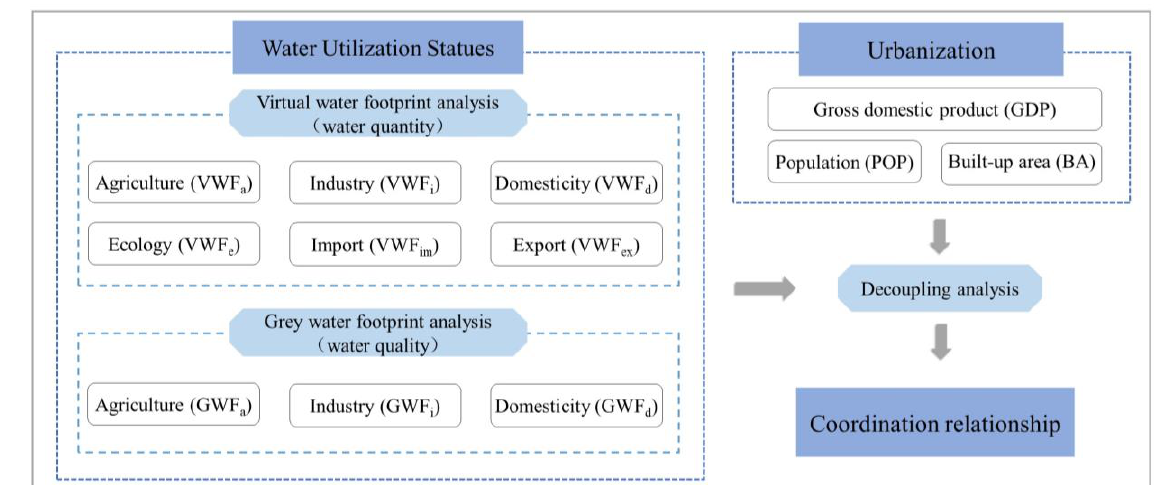
Figure 2. The research framework of this study. VWF a : agricultural virtual water footprint, VWF i : industrial virtual water footprint, VWF d : domestic virtual water footprint, VWF e : ecological virtual water footprint, VWF im : imported virtual water footprint, VWF ex : exported virtual water footprint. GWF a : agricultural grey water footprint, GWF i : industrial grey water footprint, GWF d : domestic grey water footprint.